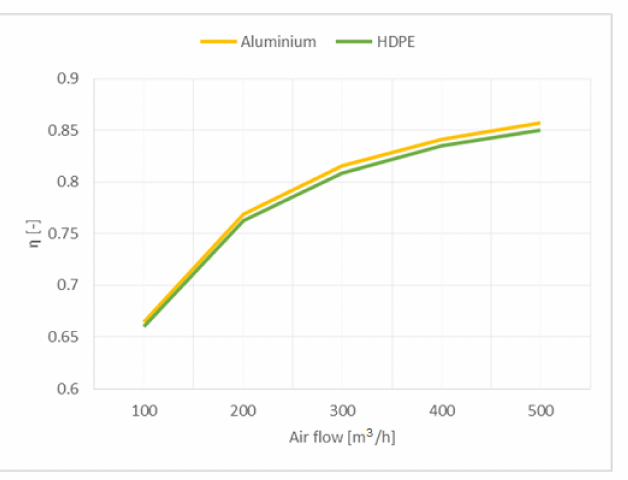
Figure 19. Evolution of the solar collector efficiency for Aluminum and HDPE